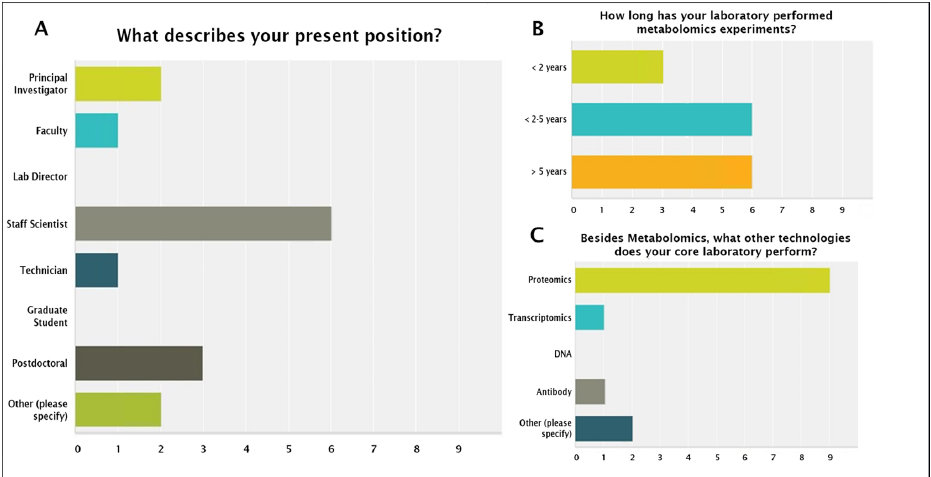
Figure 2. MRG study participants’ information.